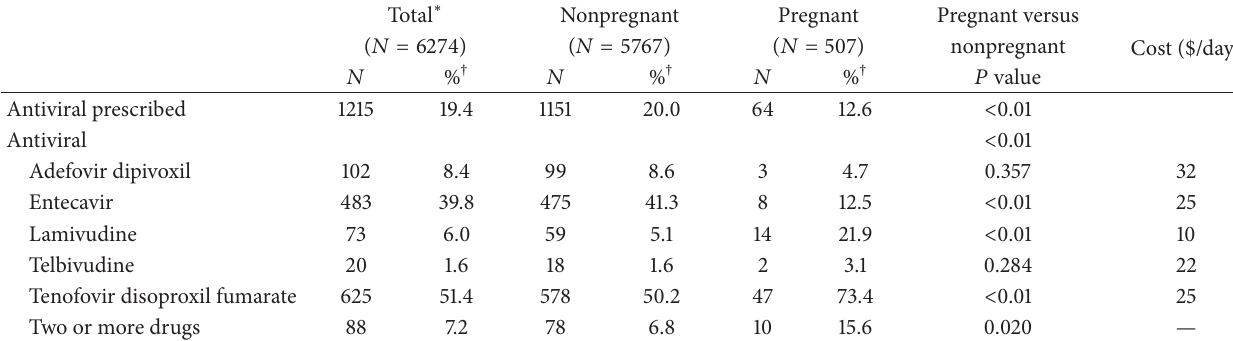
∗ Among 84 women coinfected with HIV and chronic hepatitis B virus infection, 5 (6.0%) were prescribed an antiviral, 2 (40%) adefovir dipivoxil, and 3 (60%) tenofovir disoproxil. None of the 5 coinfected women who received an antiviral was pregnant. † Percentages total more than 100% because some women received more than one